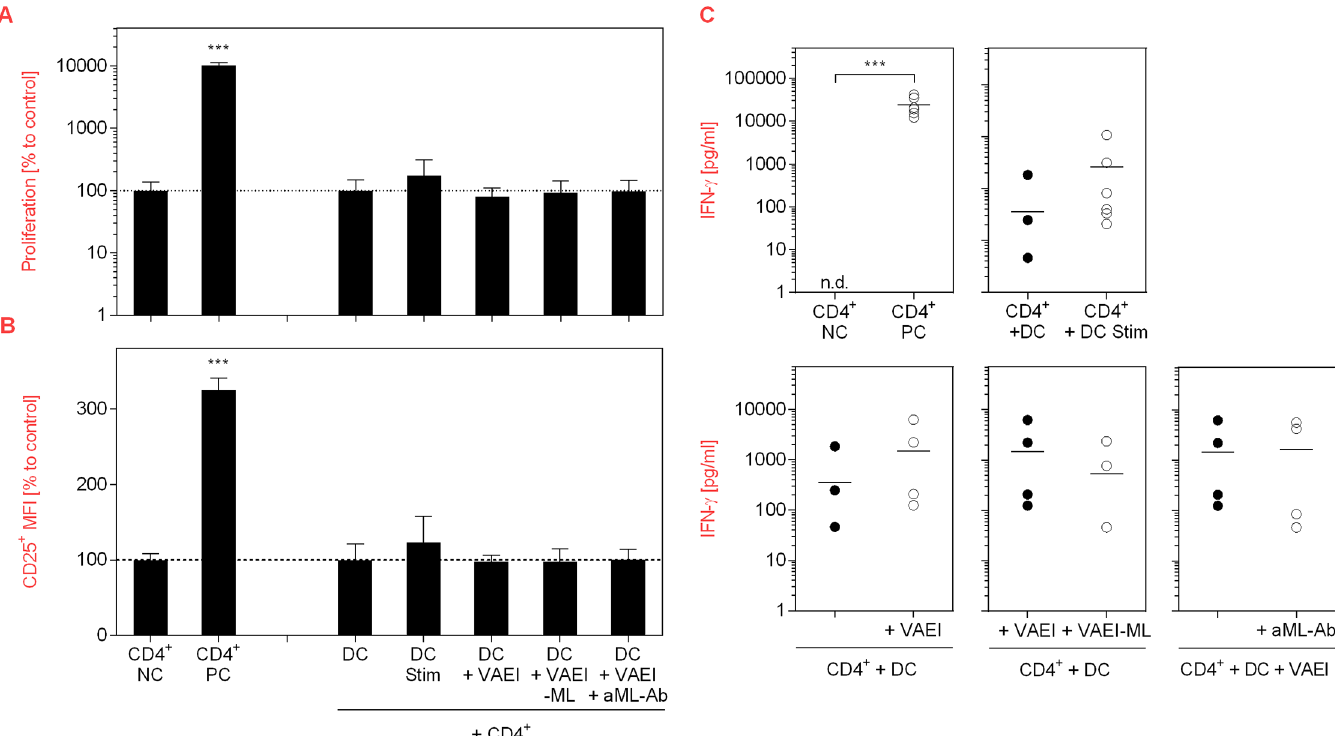
Fig 5. Effects of VAEI-treated DC on T cells. Purified humanCD4 + T lymphocytes were cultured in the presenceof medium (NC) or stimulatedwith phytohemagglutinin-L(PC; 10 μ g/ml). Unstimulated T cells were further co-cultivatedwith immature DC (DC, CD4 + ), DC treated with a maturation cocktail (DC Stim, CD4 + ; 500 ng/mL LPS; 50 ng/mL TNF-alphaand 10 ng/mL IL-1beta), VAEI-treated DC (DC + VAEI, CD4 + ; Iscador ® Qu Spez; 0.5 μ g/ml), DC incubatedwith ML-depleted VAEI (DC + VAEI-ML, CD4 + ; Iscador ® ;0.66 μ g/ml) or VAEI and anti-ML antibody (DC + VAEI + aML-Ab, CD4 + ; 2.5 μ g/ml). (A) Cell proliferation analysiswas done using CFSE stainingand flow cytometry. (B) CD25 surface marker expressionwas analyzedas a second indicatorfor T cell activation. Data of 6 individualexperiments are presented as mean ± SD in relationto untreatedT cells (NC) or untreatedT cells co-culturedwith immature DC (DC, CD4 + ). (C) IFN- γ releaseby T cells was analyzedin the supernatantsof the co-cultures of 6 independent experiments using a cytokine beadarray assay. Asterisks indicatesignificantdifferencesbetweenthe groups ( * P < 0.05, ** P < 0.01, *** P < 0.001). Data points with values below the detectionlimit are not